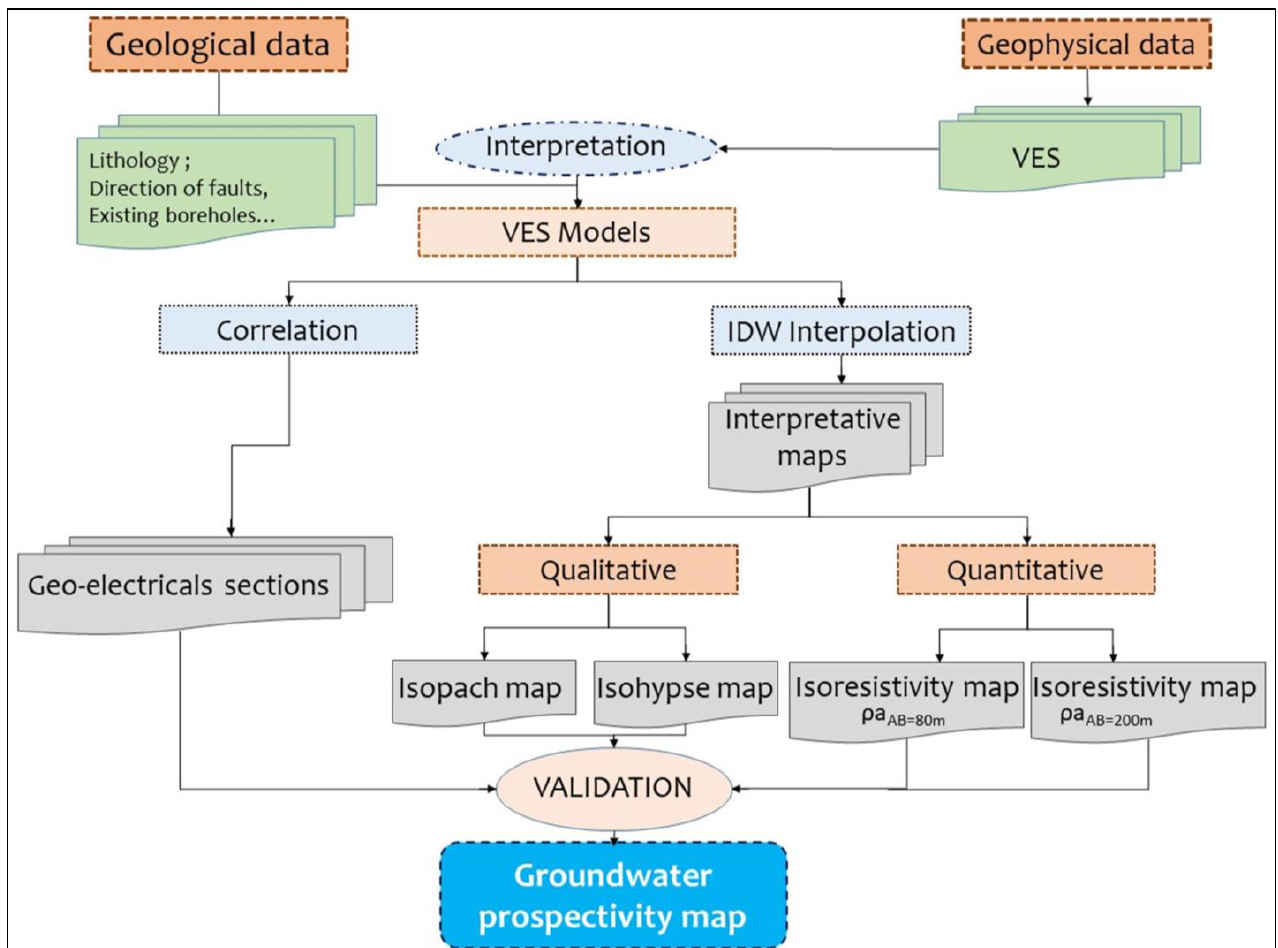
Figure 4 . The methodological flowchart used in this study . Figure 4. The methodological flowchart used in this